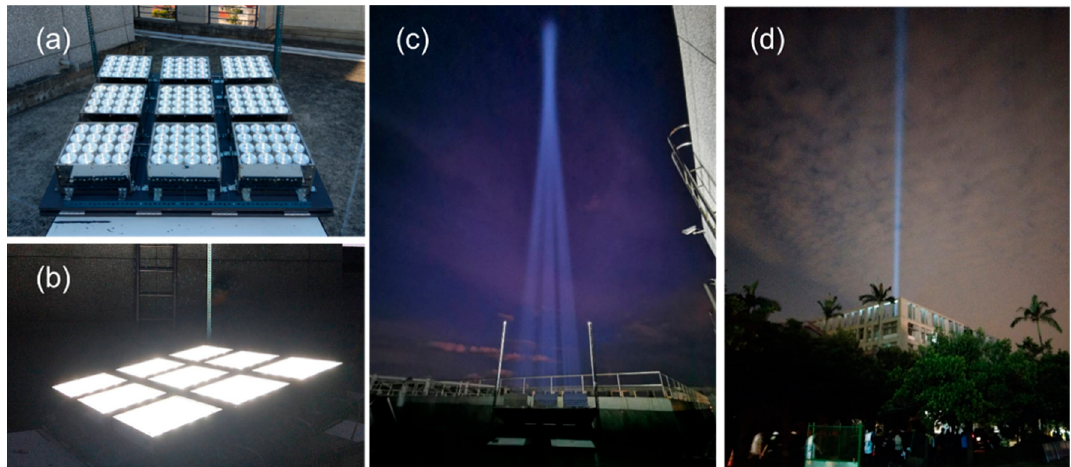
Figure 13. ( a , b ) Entire spot light system for 10-km projection; ( c ) light paths from the system; and ( d ) light path observed at a distance far away the system.